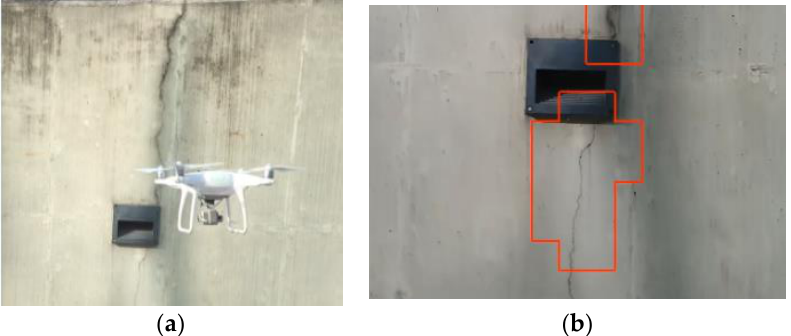
Figure 12. Automated crack detection using UAV: ( a ) Video shooting using UAV, ( b ) Example image of real-time crack detection.